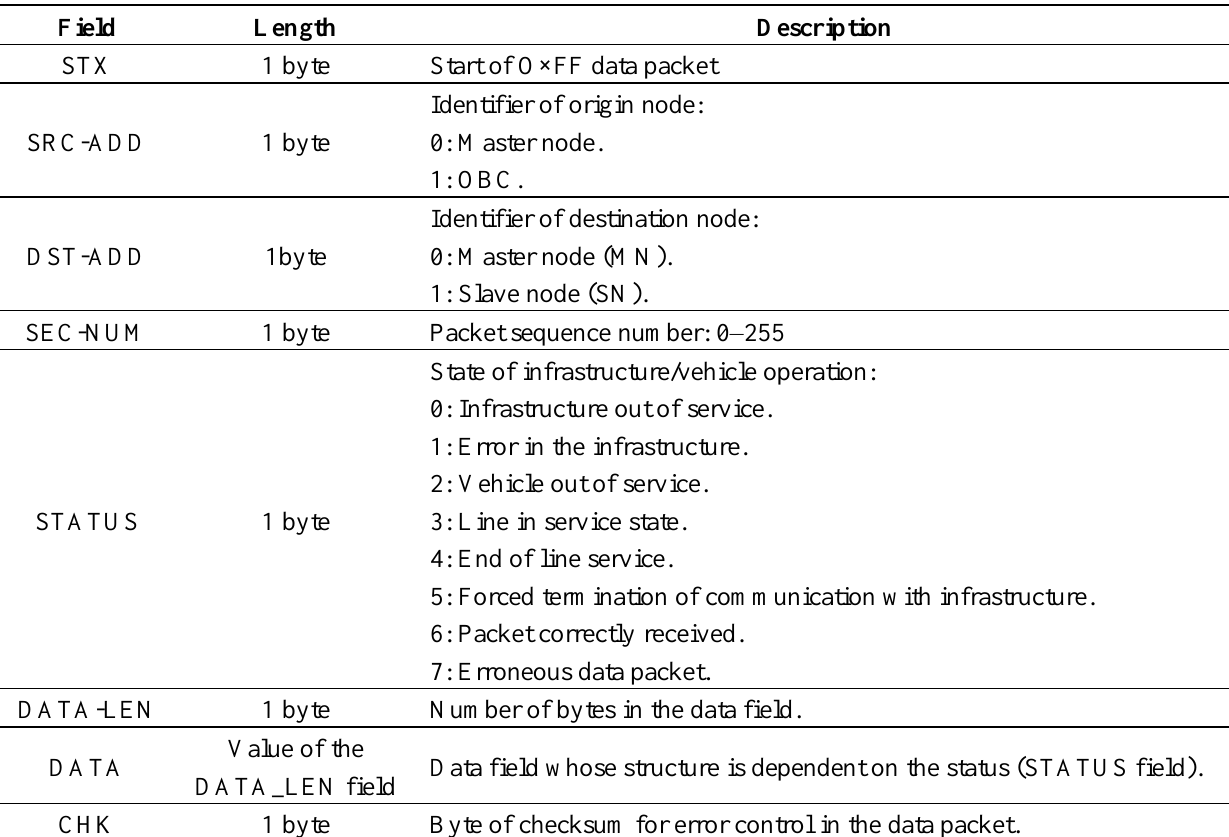
Table 4. Description of fields from the data